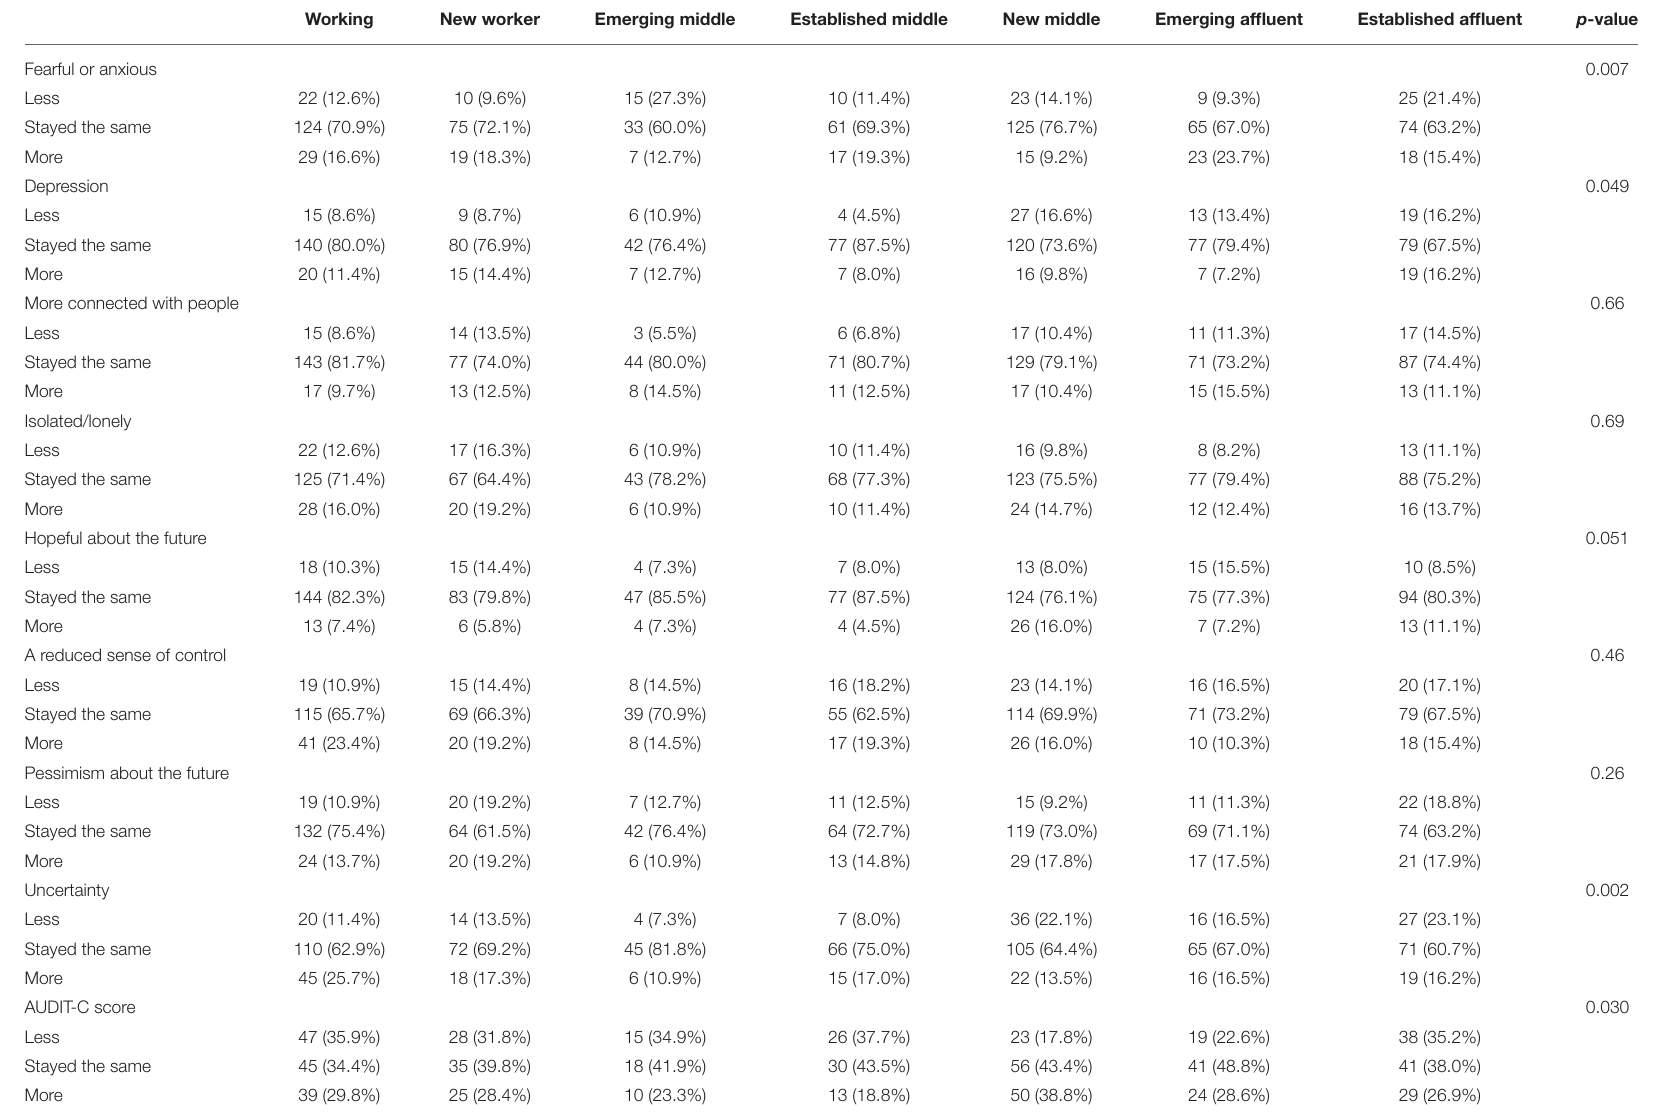
TABLE 5 | Changes in affect and AUDIT-C scores by social class group ( n = 799). Working New worker Emerging middle Established middle New middle Emerging affluent Established affluent p